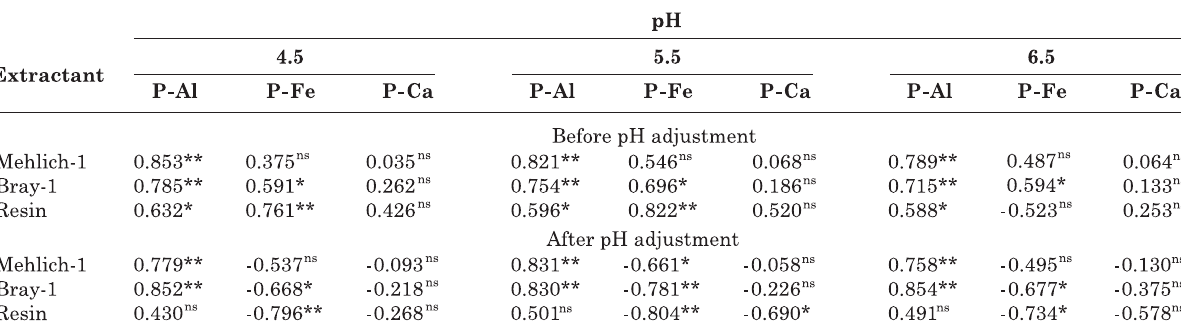
Table 9. Simple linear correlation coefficients between the forms P-Al, P-Fe and P-Ca, and the P content determined by Mehlich-1, Bray-1 and Resin extractants before and after the adjustments of different pH values to